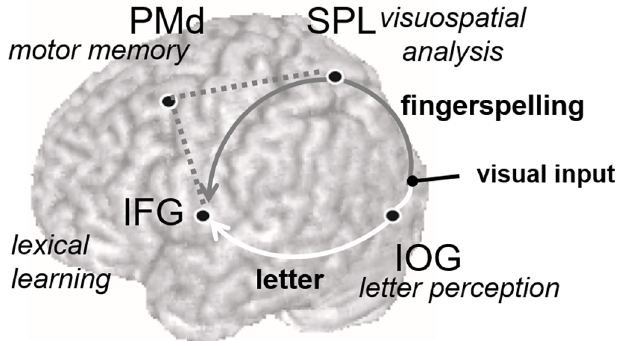
Fig 5. Modality-specific neural components for converting letter and fingerspelling inputs into phonological STM during verbal learning. The left IOG involvedin letter perception is known to have fast and direct connections with the left IFG involvedin speech productionand lexicallearning.This ventral occpitofrontal connectionconstitutes a specific neuralpathway involvedin verbal learningvia letter inputs (white line). The dorsal parietofrontal connectionlinkingthe left SPL with the left IFG serves as a visuomotor pathway for verballearningvia sign languagelearning(gray line). The left PMd selectivelyactivated by fingerspellinginputs is also known to have structural and functionalcouplingwith the posterior parietal and inferior frontal regions [23] and thus likely to operate with this dorsalneural system (dotted line).